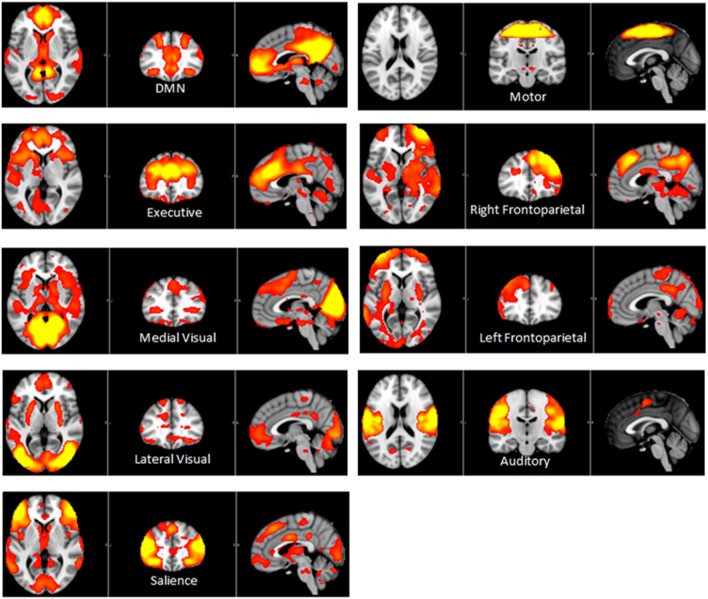
Axial, coronal and sagittal slices for the main RSNs detected, overlaid onto the standard MNI brain.